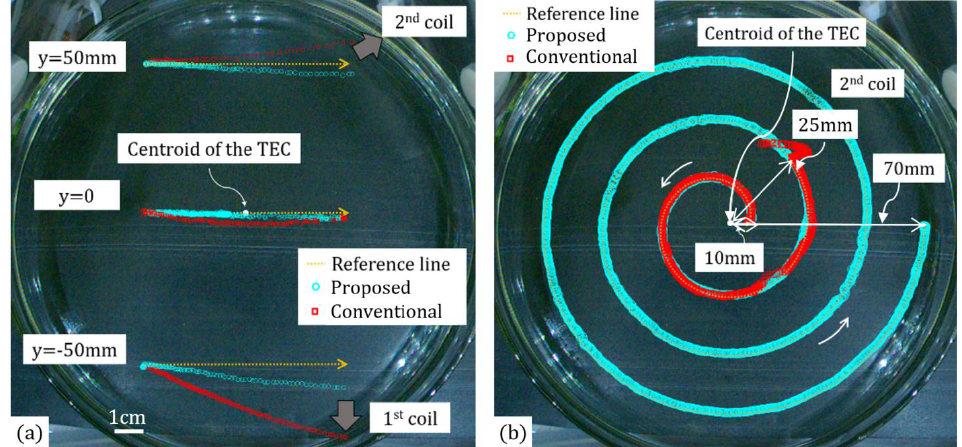
Figure 7. ( a ) Open-loop manipulation trajectories of the microrobot along three straight pathways actuated by the conventional and proposed manipulation methods. ( b ) Closed-loop manipulation trajectories of the microrobot along a spiral pathway actuated by the conventional and proposed manipulation methods. (See supplemental Videos).